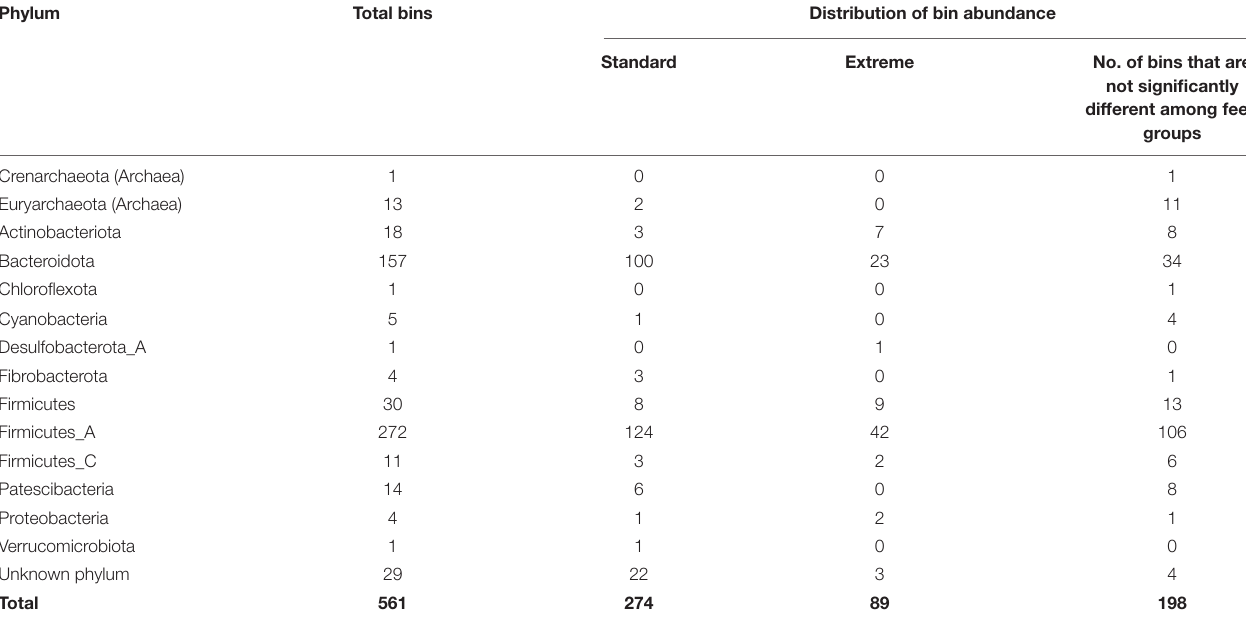
TABLE 4 | Inspection of the abundance changes for the individual bins without each of the phyla. Phylum Total bins Distribution of bin abundance